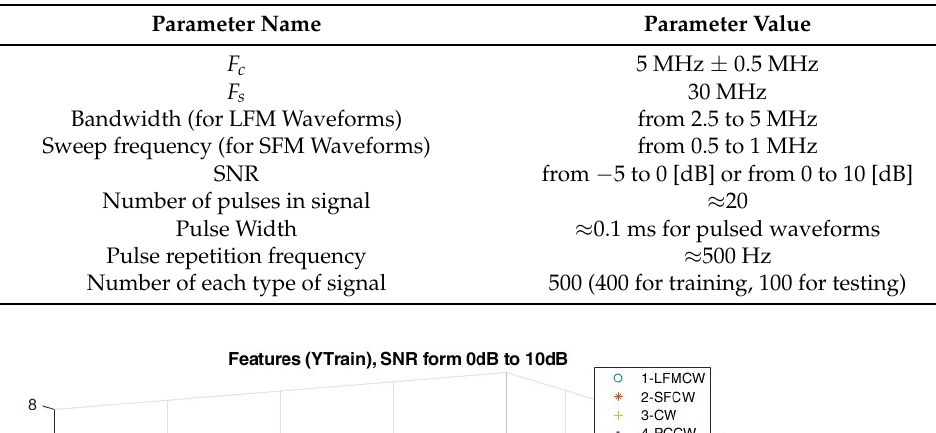
Table 1. This is a table caption. Tables should be placed in the main text near to the first time they are cited.